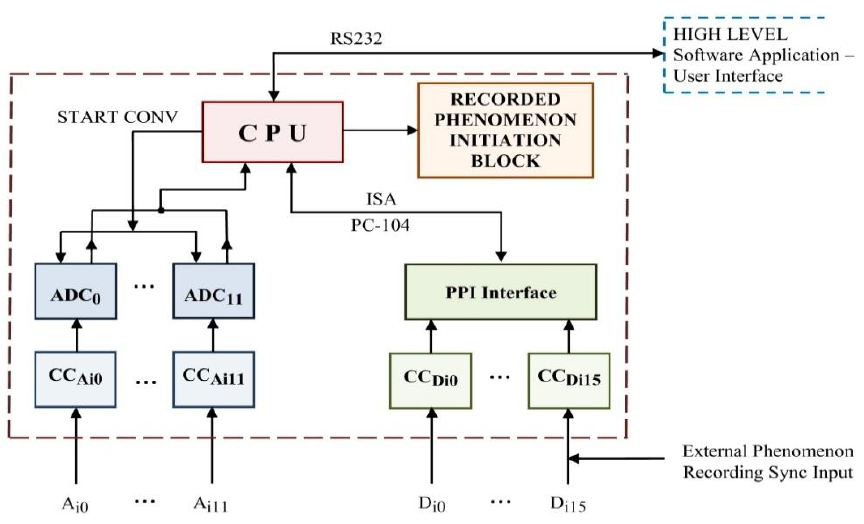
Figure 1. Hardware structure elaborated for the required system.